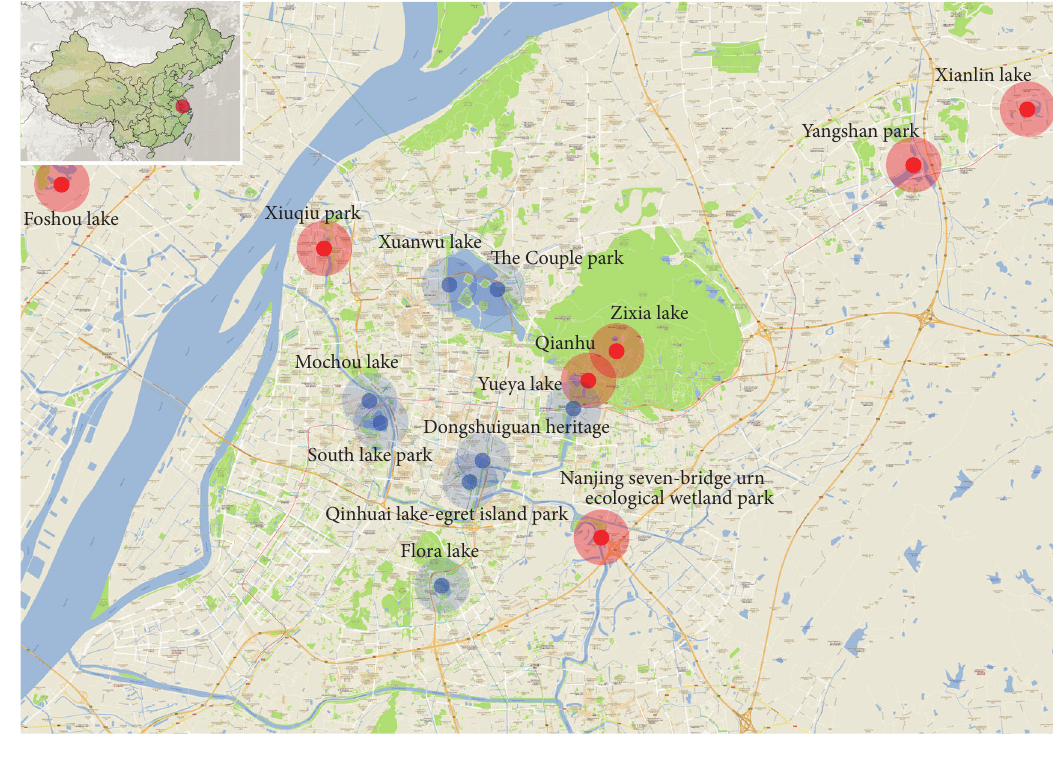
Figure 1: Fifteen research sites in Nanjing.